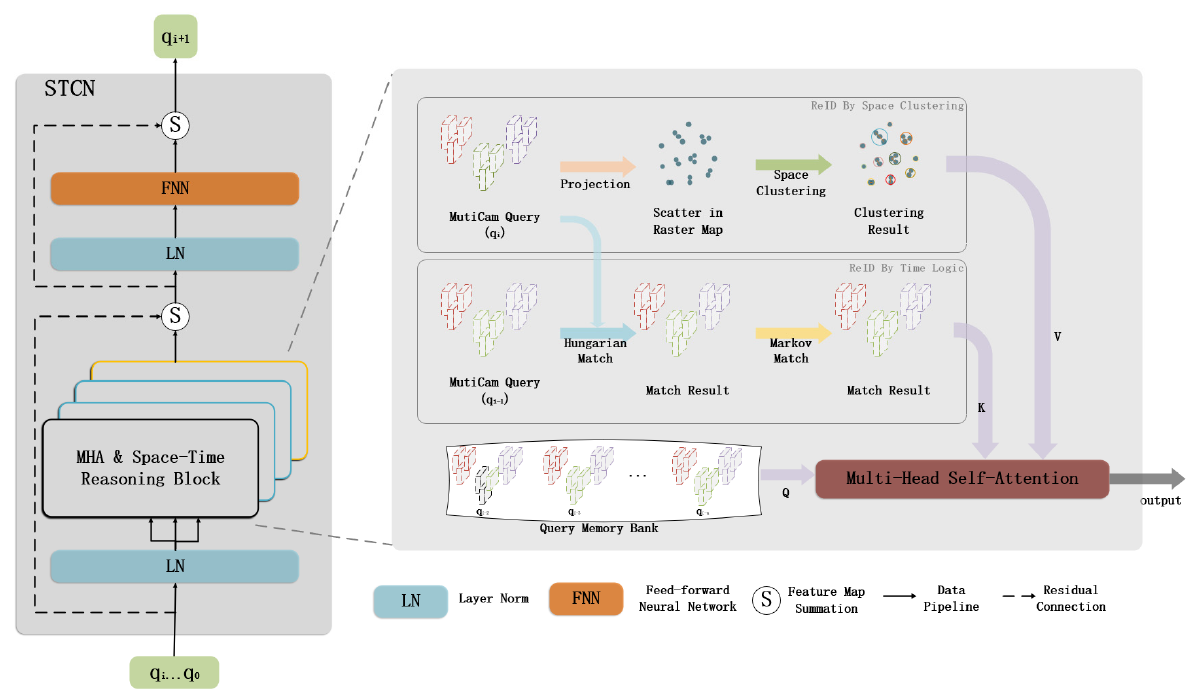
Figure 3. STCN structure diagram.